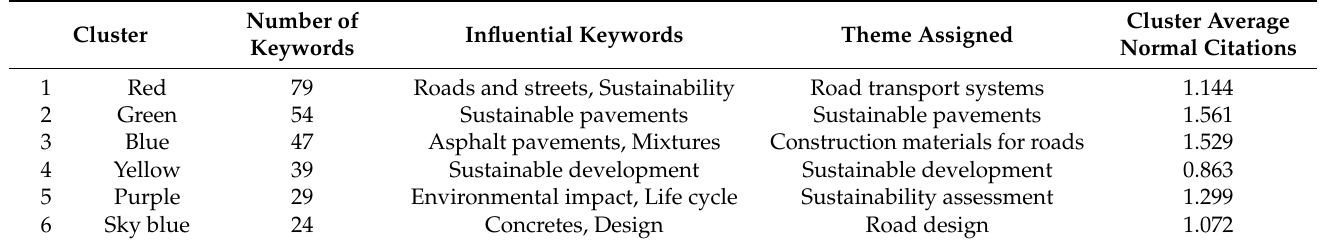
Table 6. Description of keywords clusters in terms of number and influential keyword, theme assigned and average normal citation of the